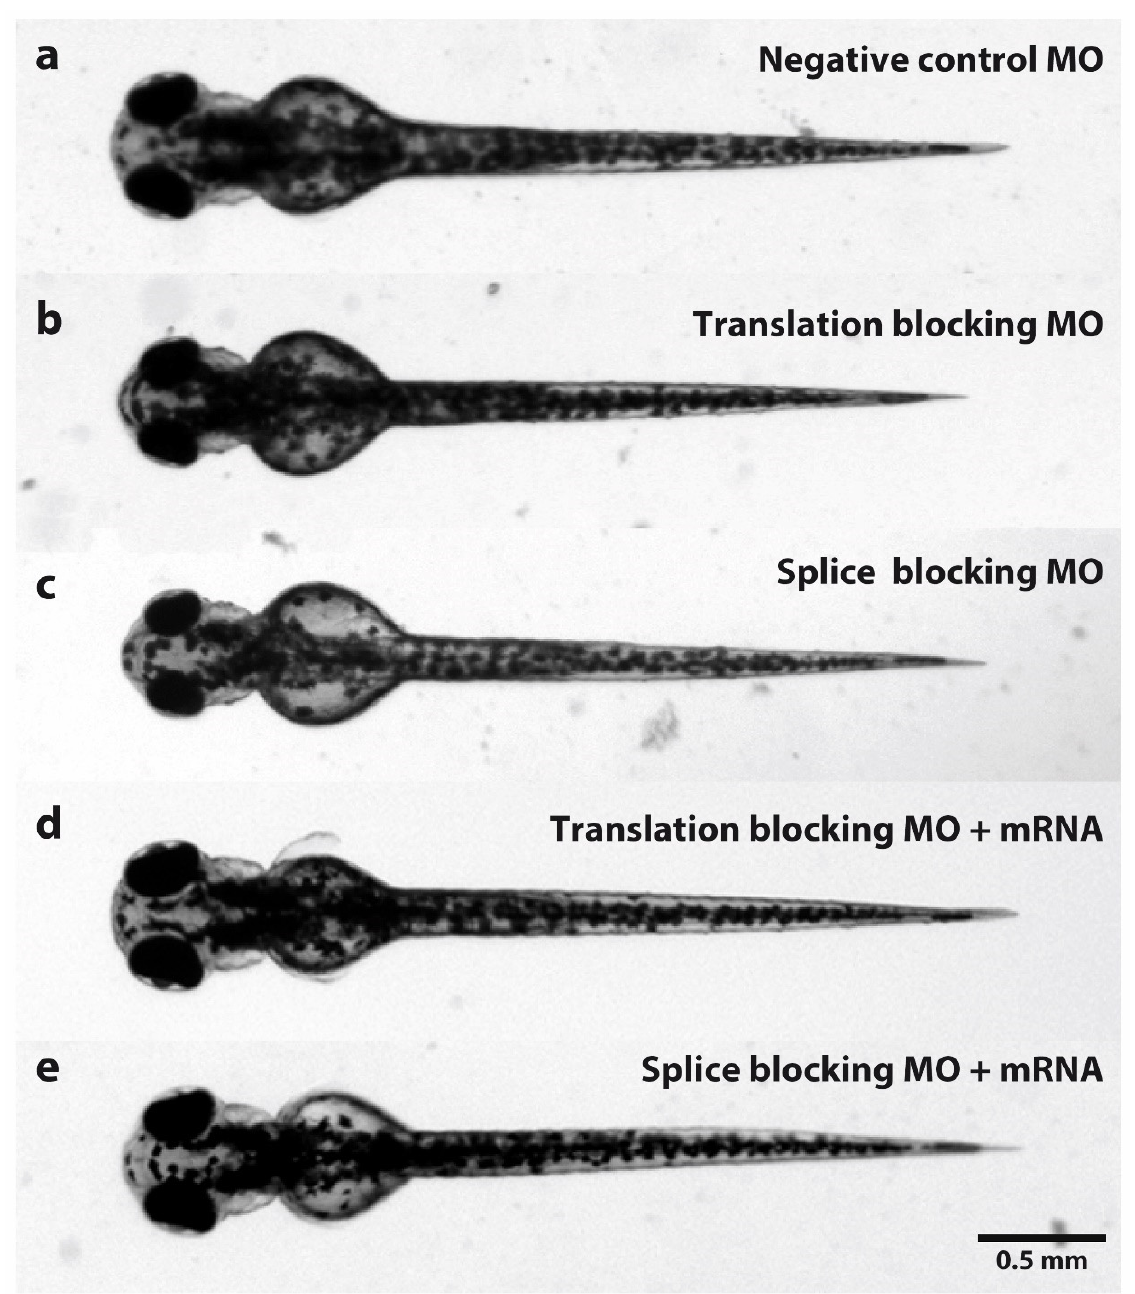
Figure 1. Dorsal view comparison of zebrafish larvae at 3 dpf injected with MOs. ( a ) Standard control oligo was injected as a negative control. ( b ) Zebrafish larvae injected with tubgcp2 translation-blocking MO. ( c ) Zebrafish larvae injected with tubgcp2 splice-blocking MO. ( d ) Zebrafish larvae co-injected with tubgcp2 translation-blocking MO and tubgcp2 wild type mRNA. ( e ) Zebrafish larvae co-injected with tubgcp2 splice MO and tubgcp2 wild type